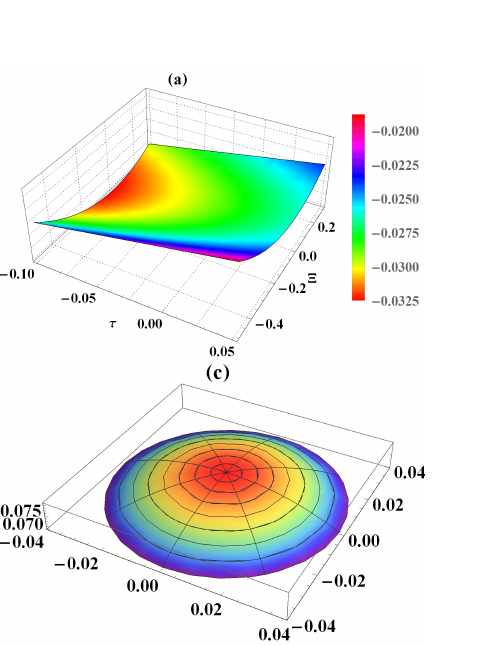
Figure 4. Solitary wave solution of Equation (33) in ( a ) three–dimension, ( b ) density and ( c ) spherical plot three–dimensional for a = 2, (cid:36) = 0.5.